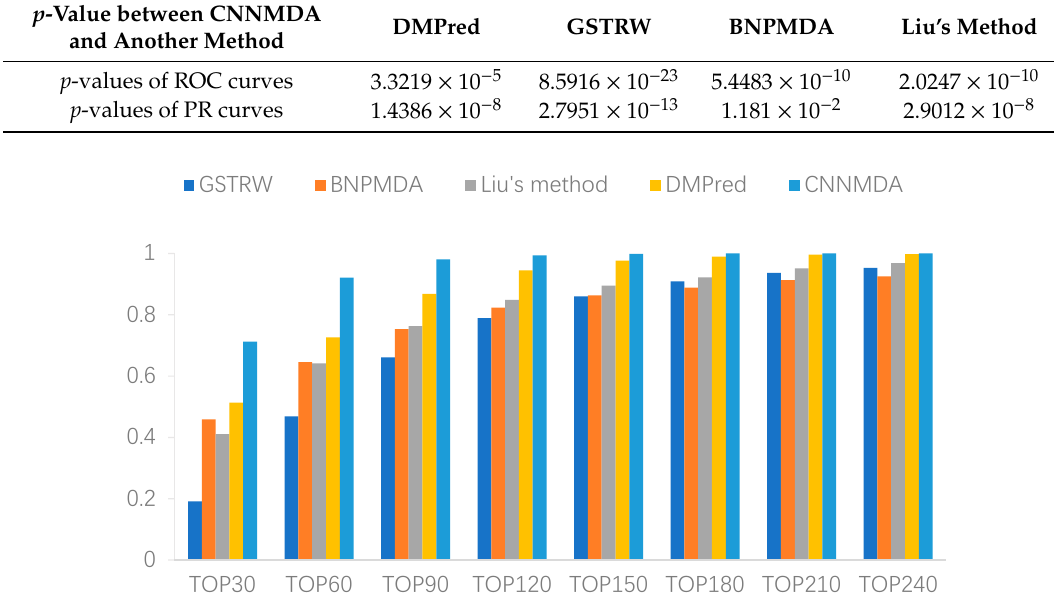
Figure 2. Recall values of top k candidates of CNNMDA and the other four methods.